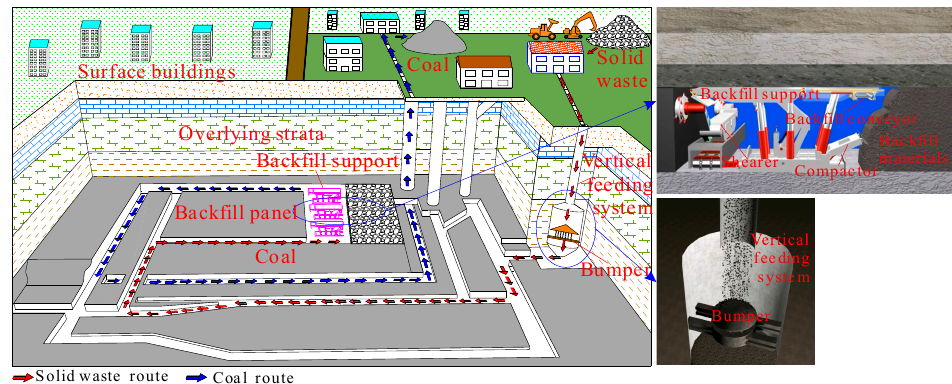
Figure 1. Schematic diagram of the SBCM technique.